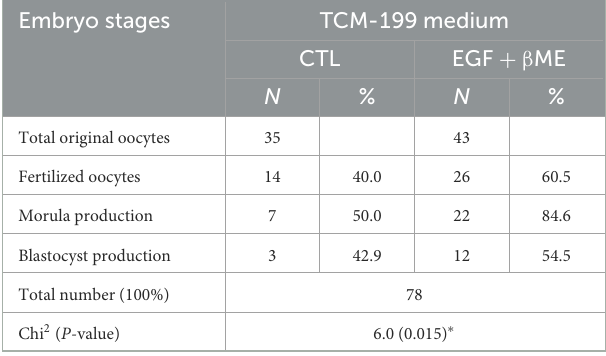
TABLE 3 Effects of combined EGF and β ME supplementations to the TCM-199 medium on the embryo stages; cleavage and gastrulation. Embryo stages